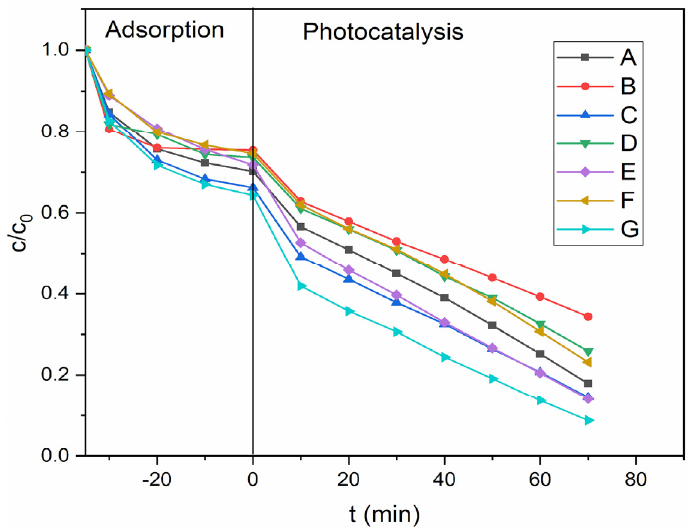
Figure 3. Adsorption and photocatalytic degradation of PB with different prepared samples ( γ (TiO 2 ) = 0.25 g/L).